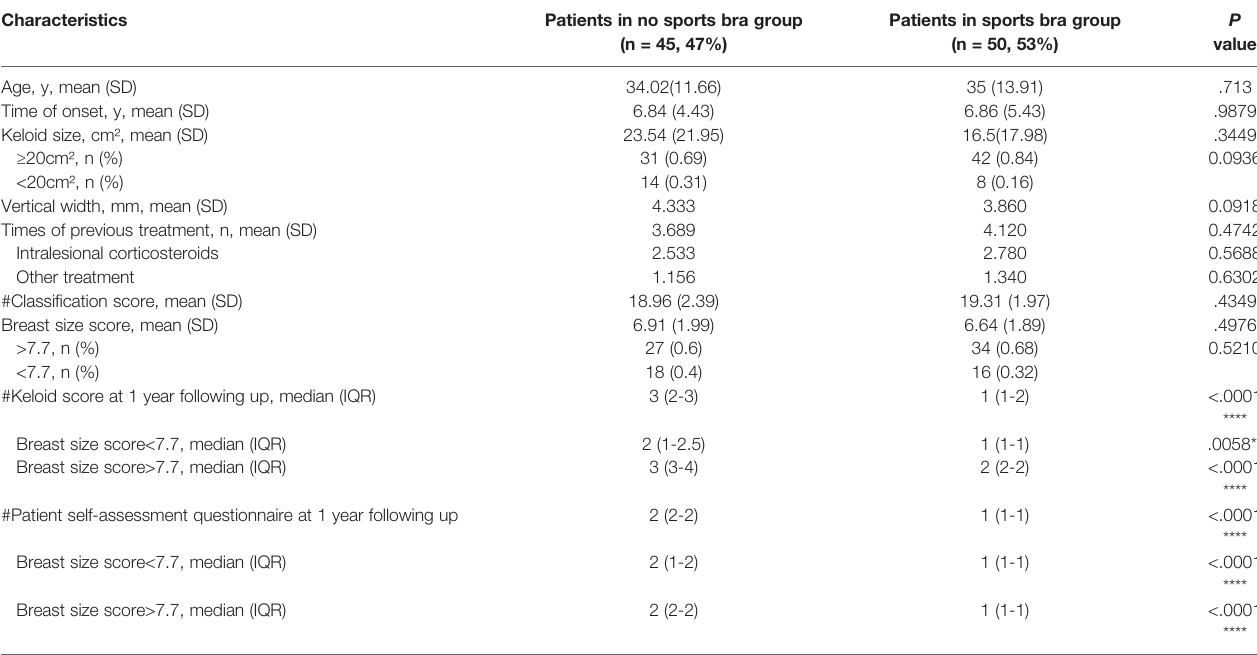
TABLE 1 | Demographic and clinical characteristics of female patients with prothoracic keloid.